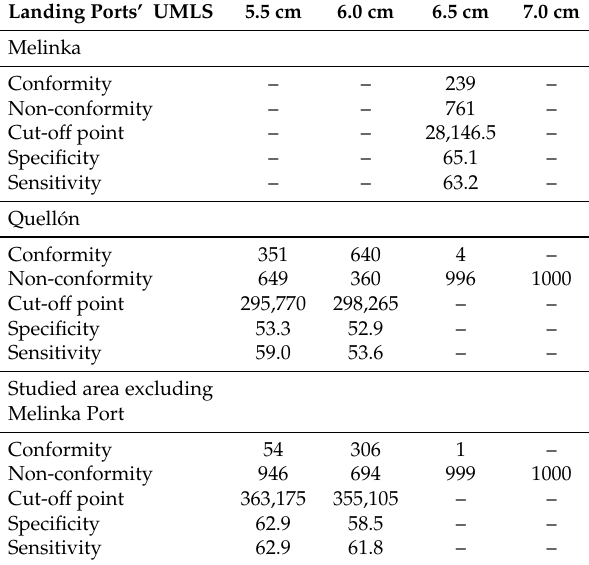
Table 3. Evaluation of the conformity of boxes, for Melinka Port, Quellón Port, and the complete data excluding Melinka Port, according to the simulation of 1000 boxes with urchin, considering different under the minimum legal size (UMLS)